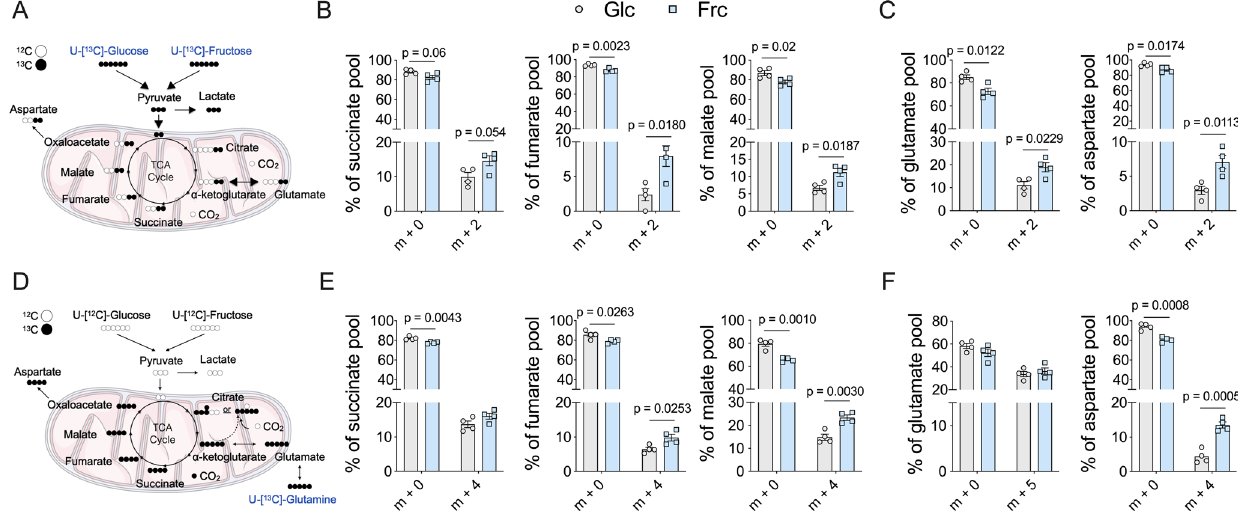
Fig. 5 Fructose treatment induces elevated metabolic cycling. A Stable isotope tracing of uniformly labelled 13 C-glucose or 13 C-fructose into the TCA cycle. B Mass isotopologue distribution (MID) represented as a % pool of TCA cycle metabolites: succinate, fumarate and malate or C amino acids: glutamate and aspartate of 24-h LPS-stimulated monocytes. Numbers on the x -axis represent the number of 13 Carbons incorporated. D Stable isotope tracing of uniformly labelled 13 C-glutamine in the presence of 12 C-glucose or 12 C-fructose of 24-h LPS-stimulated monocytes. E MID of succinate, fumarate and malate and F amino acids: glutamate and aspartate. Statistical signi fi cance of individual mass isotopomers was assessed using an unpaired, two-tailed t test ( B , C , E , F ). Data are representative of four independent experiments and are expressed as mean ± SEM. Source data are provided as a Source Data fi